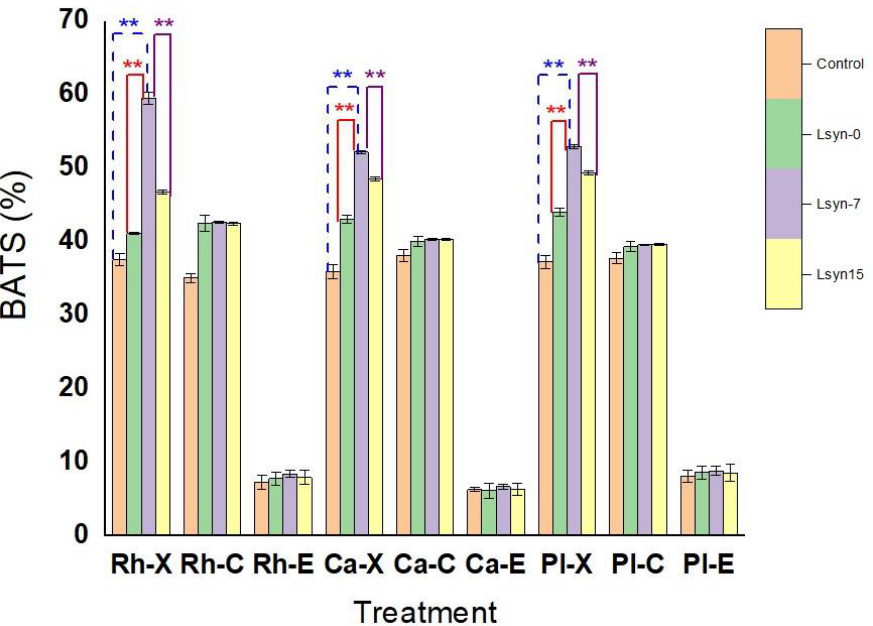
Figure 1. The influence of postbiotics (L syn − 0 , L syn − 7 and L syn − 15 ) on affinities of selected probiotics ( L. rhamnosus (Rh), L. casei (Ca) and L. plantarum (Pl) to xylene (X), chloroform (C), and ethyl acetate (E). ** p < 0.01.